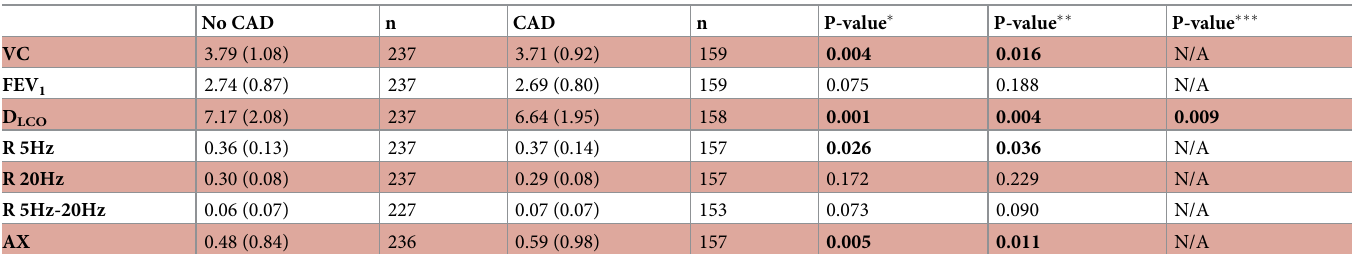
Table 2. Mean spirometry and IOS measurements in non-CAD and CAD patients.